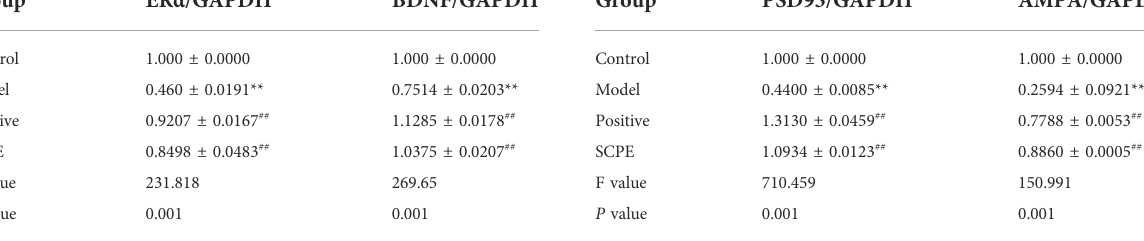
TABLE 7 Protein expression of ER α and BDNF in hippocampus of D-galactose model mice by SCPE (mean ± SD, n = 3). Group